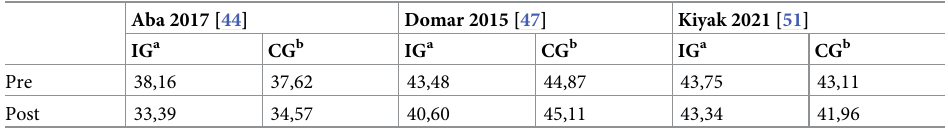
Table 5. State-STAI Means pre-treatment and